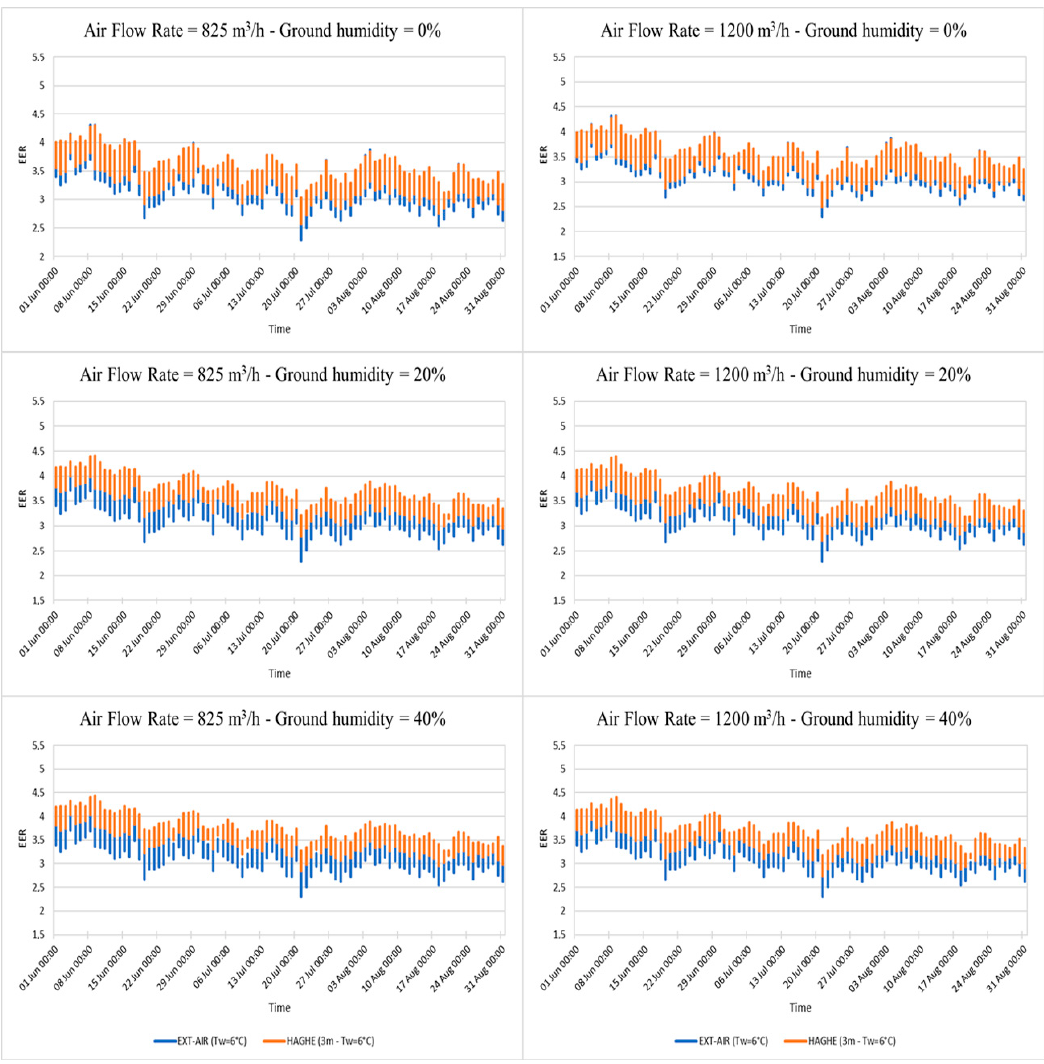
Figure 7. Summer comparison between EER EXT ‐ AIR and EER HAGHE by varying air flow rate and ground humidity: 1 June–31 August, T w = 6 °C, H = 3 m, L = 30 m.